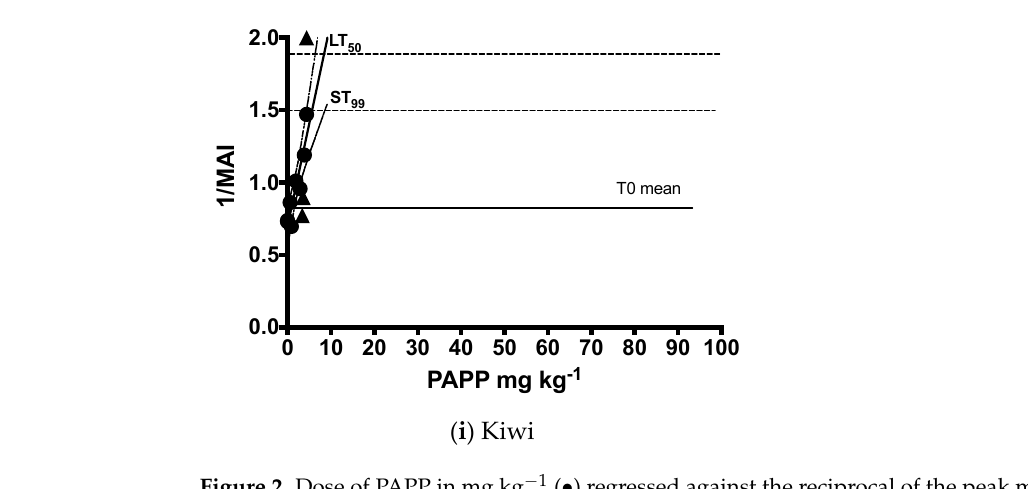
Figure 2. Dose of PAPP in mg kg − 1 ( • ) regressed against the reciprocal of the peak methaemoglobin absorbance index (1/MAI) observed at either T1 (60 min) or T2 (180 min) with upper and lower confidence ( p < 0.05). Lethal outcomes are denoted as acute (A) or protracted (P) if they occurred >24 h later. Horizontal lines denote the mean 1/MAI T0 value prior to gavage with PAPP. The ST 99 threshold denotes when 99% of birds are expected to survive, and the LT 50 , where 50% of birds are expected to die. Outliers ( (cid:78) ) were not considered in the model—see text. Table 2. Estimation of PAPP doses (mg kg − 1 ) in each bird species required to achieve the four thresh ‐ old values (1 SD, 2 SDs, ST 99 and LT 50 ) with upper and lower confidence ( p < 0.05).